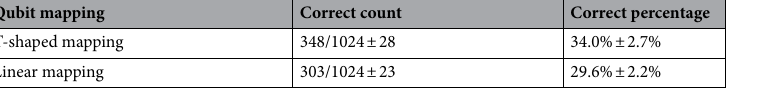
Fig. 1g. Qubit 1 connects to three qubits, qubits 0, 2 and 3, while qubit 4 connects only to qubit 3. Due to the high connectivity of qubit 1, we assume that mapping one of the data qubits (q 0 or q 1 in Fig. 1c) to physical qubit